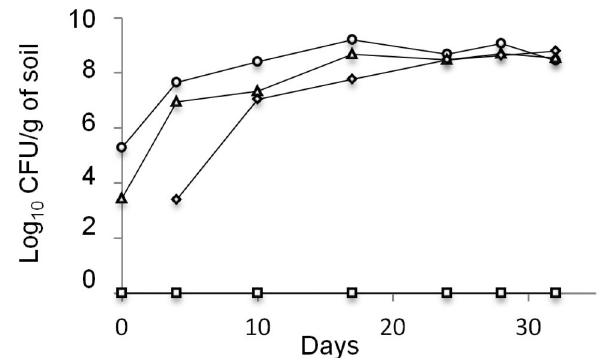
Figure 1. Bacterial communities implantation in γ-sterilised soils over a 32-days period. Undiluted (○), 10 2 - (Δ) and 10 4 - diluted ( ) populations and control sterilized soil (□). ◊